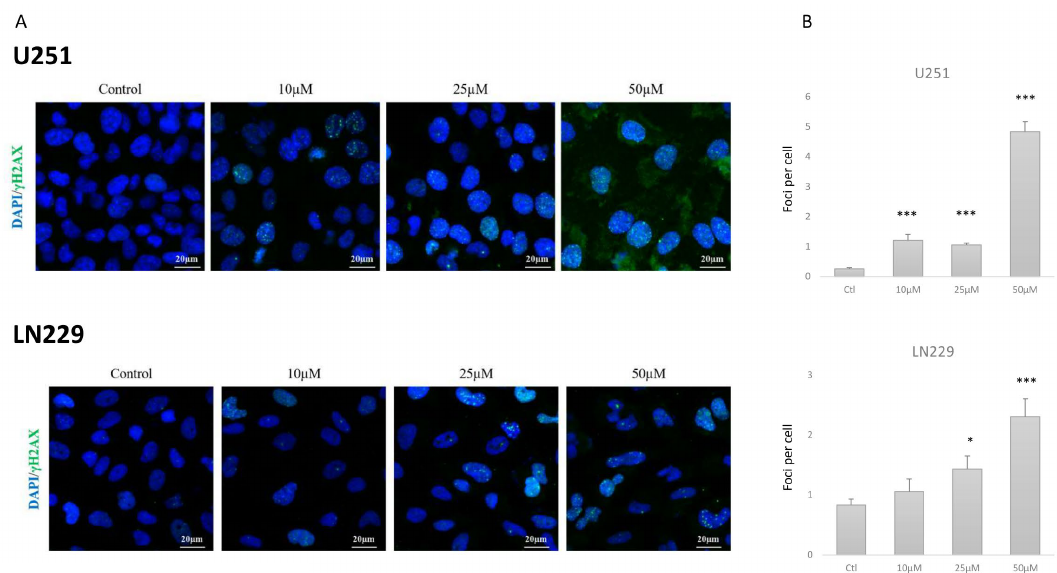
Figure 3. Cont . Figure 3.